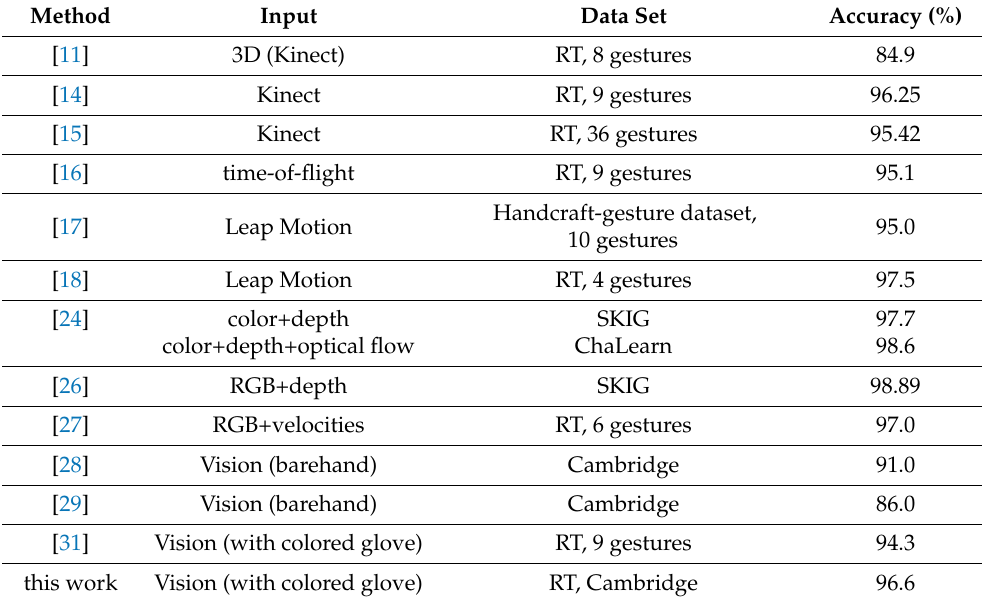
Table 4. Comparison of